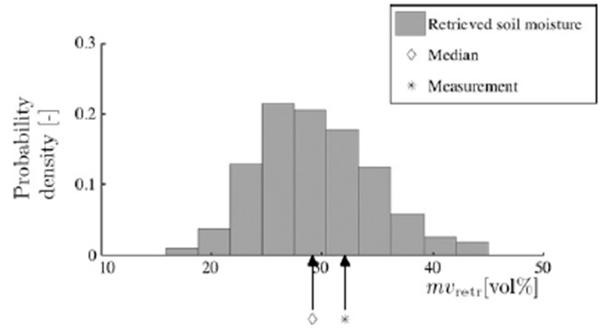
Figure 4. A histogram of retrieved soil moisture content (mv retr ) [102].